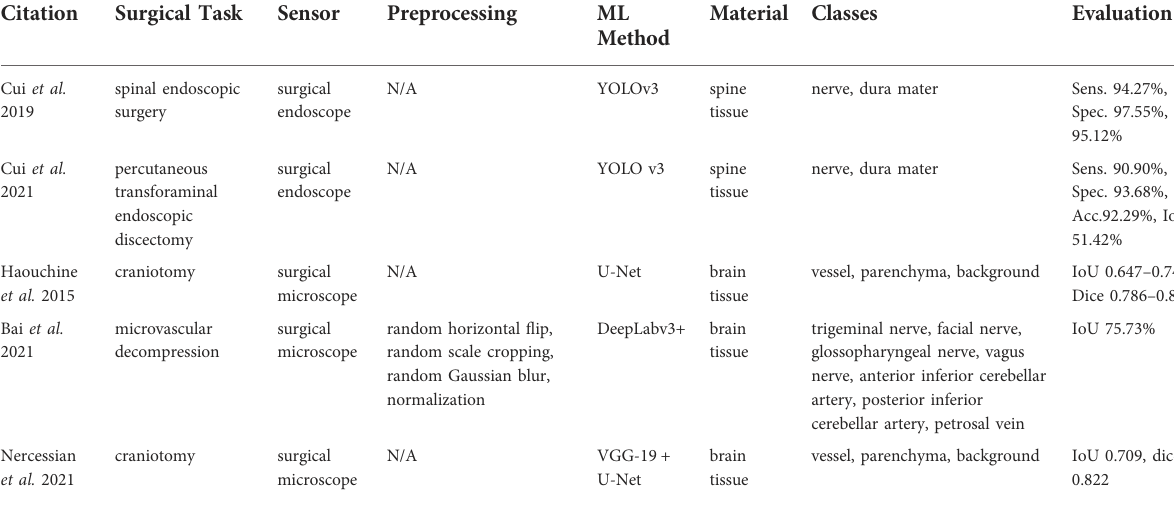
TABLE 8 General description of selected paper related to microscopic and endoscopic imaging. Citation